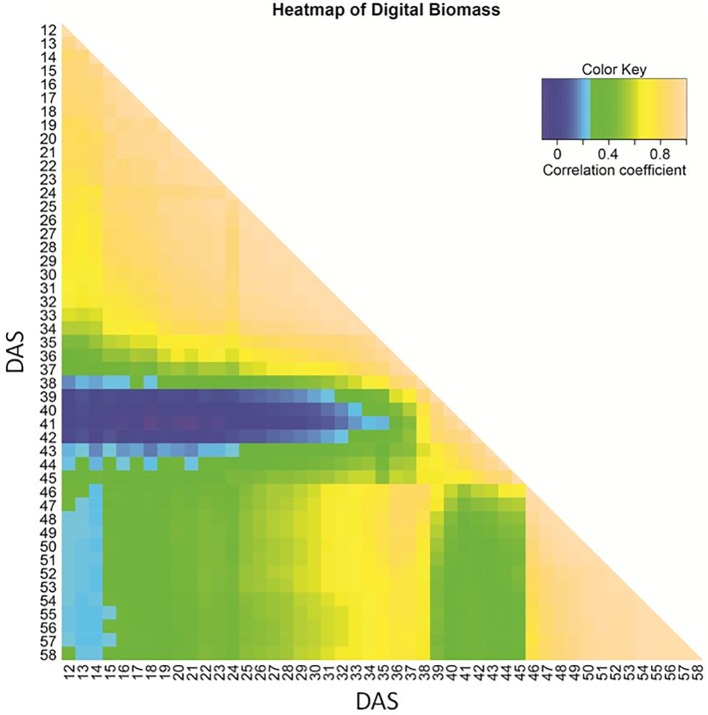
Heat map of Kendall correlation coefficient for image-based estimated biomass based on BLUEs across three experiments, shown from 12 to 58 days after sowing (DAS).